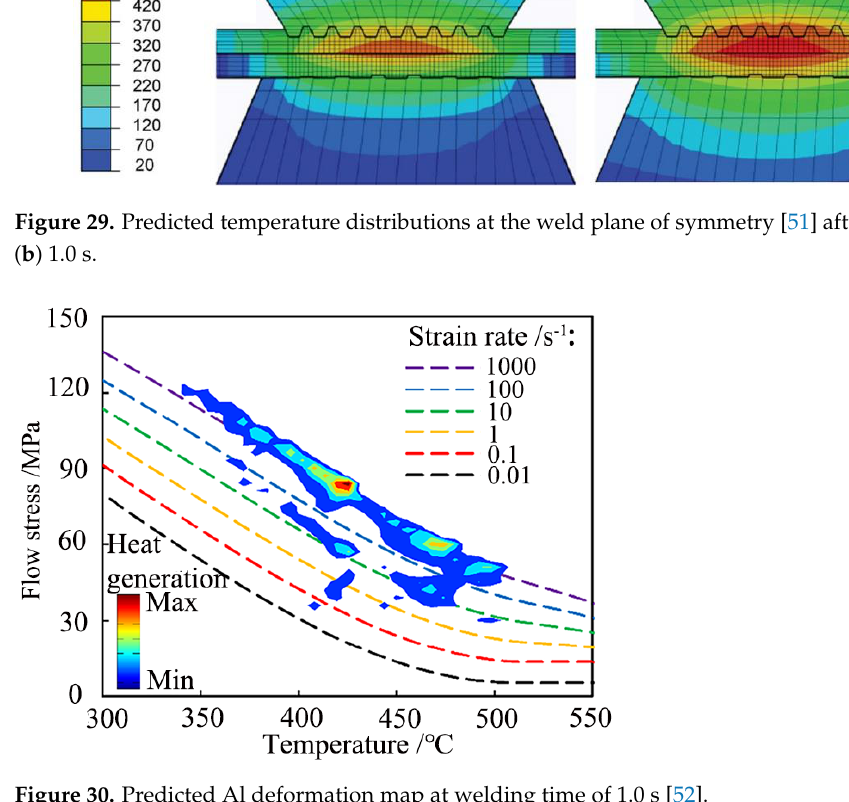
Figure 30. Predicted Al deformation map at welding time of 1.0 s [52].